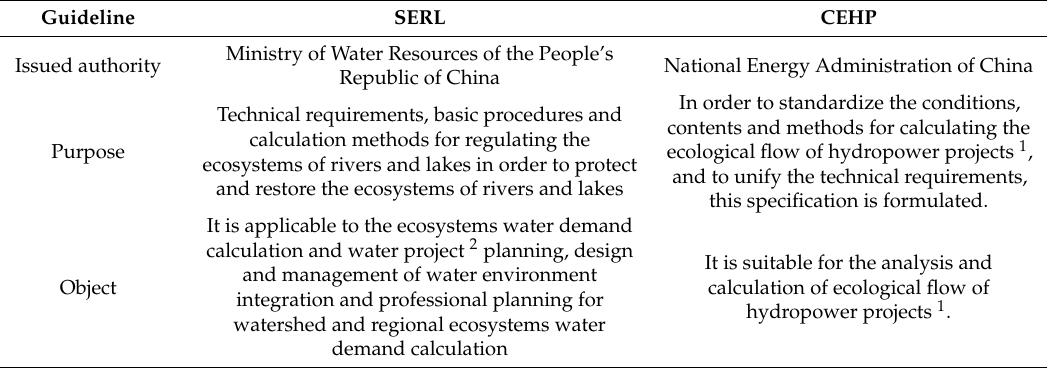
Table 2. Comparison of the two standards for development of water use projects for calculating environmental flows in